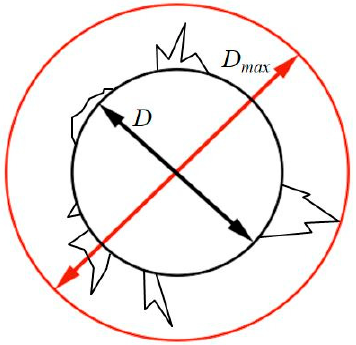
Figure 3. Schematic diagram for determining delamination factor (F d ).